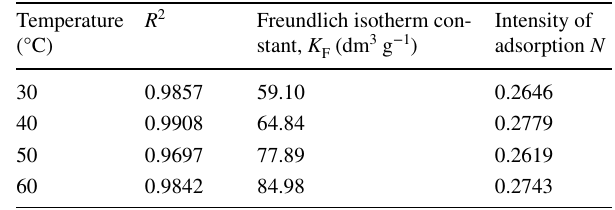
Table 4 Freundlich isotherm parameters for adsorption of methylene blue on coconut coir dust with varying